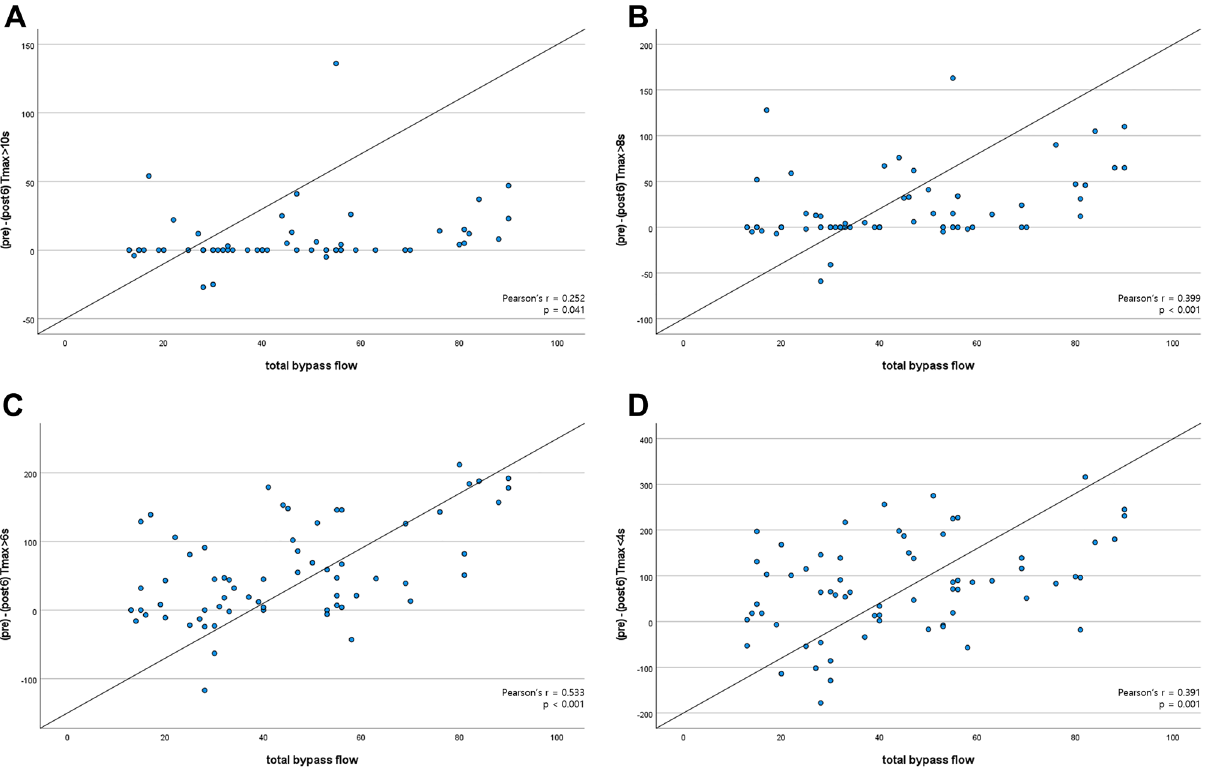
amount of STA flow measured during surgery (Pearson’s r = 0.391, p =